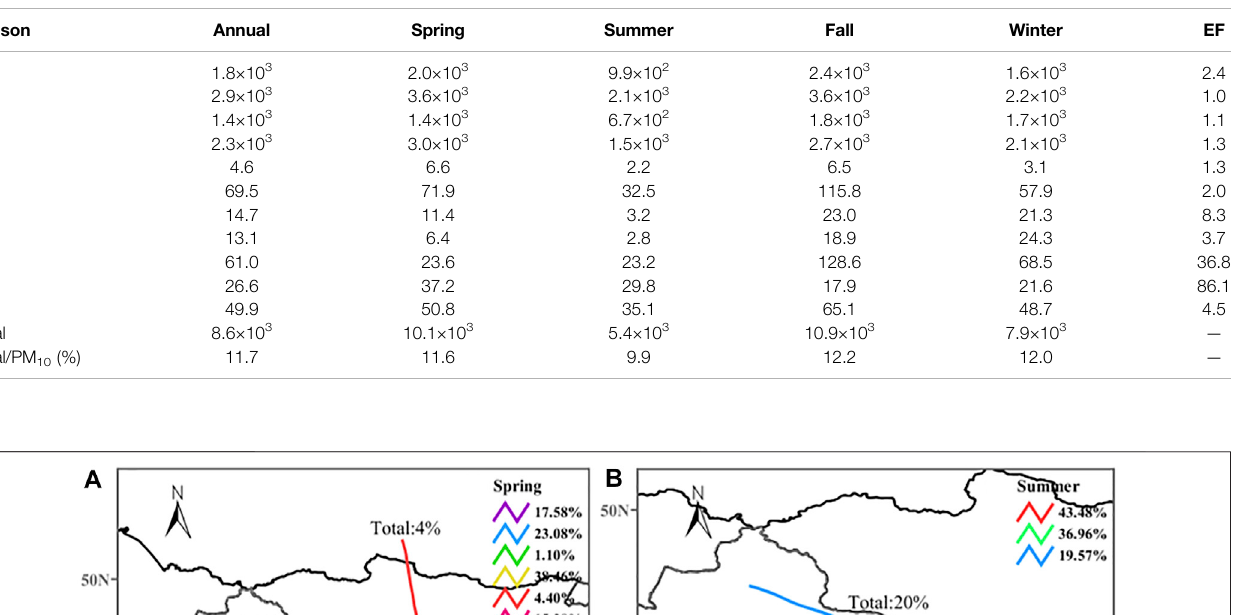
TABLE 3 | Seasonal distribution of inorganic elements mass concentrations in four seasons in Jiuquan city during the entire sampling period (ng/m 3 ).